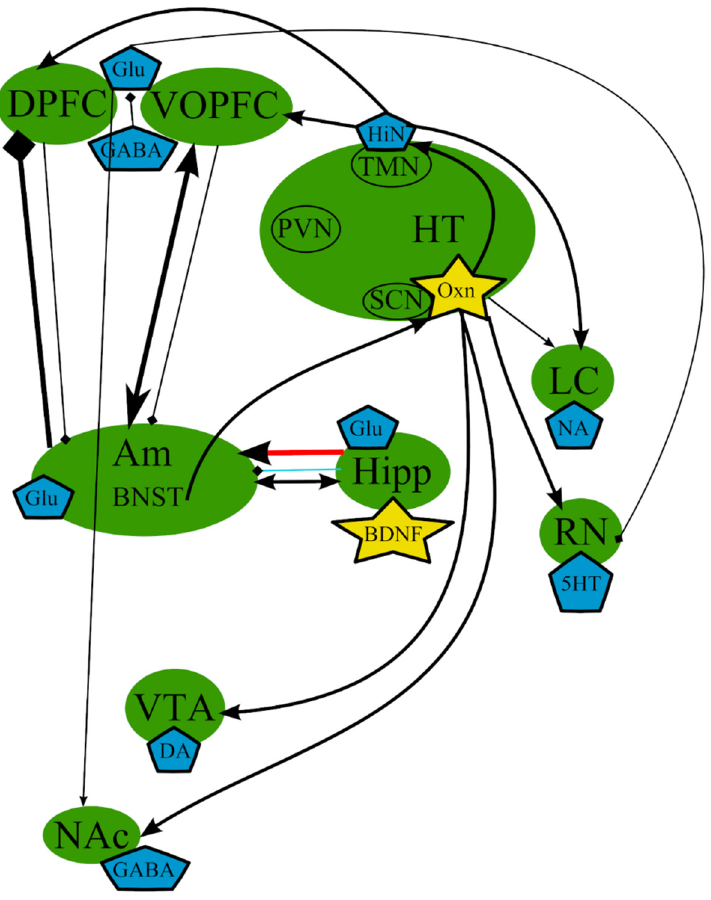
Figure 4. The circadian hypothesis: main brain structures, neurotransmitters, biologically active substances, and interactions. Am—amygdala; AVP—arginine-vasopressin; BDNF—brain-derived neurotrophic factor; BNST—bed nuclei stria terminalis; CRF—corticotropin-releasing factor; DA—dopamine; DPFC—dorsal prefrontal cortex; Glu—glutamine; GABA—gamma-aminobutyric acid; HiN—histamine; Hipp—hippocampus; HT—serotonin; Hyp—hypophysis; LC—locus ceruleus; NA—noradrenaline; NAc—nucleus accumbens; Oxn—orexin; SCN—suprachiasmatic nucleus; TMN—tuberomammilar nucleus; RN—raphe nucleus; PVN—paraventricular nucleus; VOPFC—ventral and orbital prefrontal cortex; VTA—ventral tegmental area; -> (arrow): activating effect; -<> (rhombus): a black rhombus—inhibitory effect; thick line—effect is increased; thin line—effect is decreased; medium thickness line—effect is not changed or alterations of the effect are unknown; red line—noradrenaline effect (most of them were omitted to simplify the figure); blue line—serotonin effect (most of them were omitted to simplify the figure); black line—various neurotransmitters or neuropeptides.